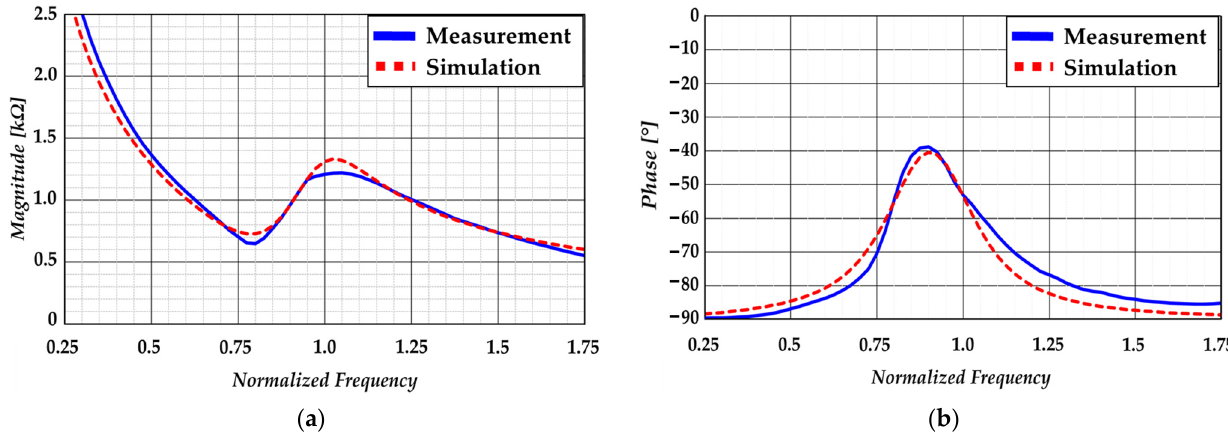
Figure 3. The estimated impedance magnitude and phase compared with the measured impedance: ( a ) the impedance magnitude; ( b ) the impedance phase. Table 1. The estimated parameters of the electrical equivalent model.